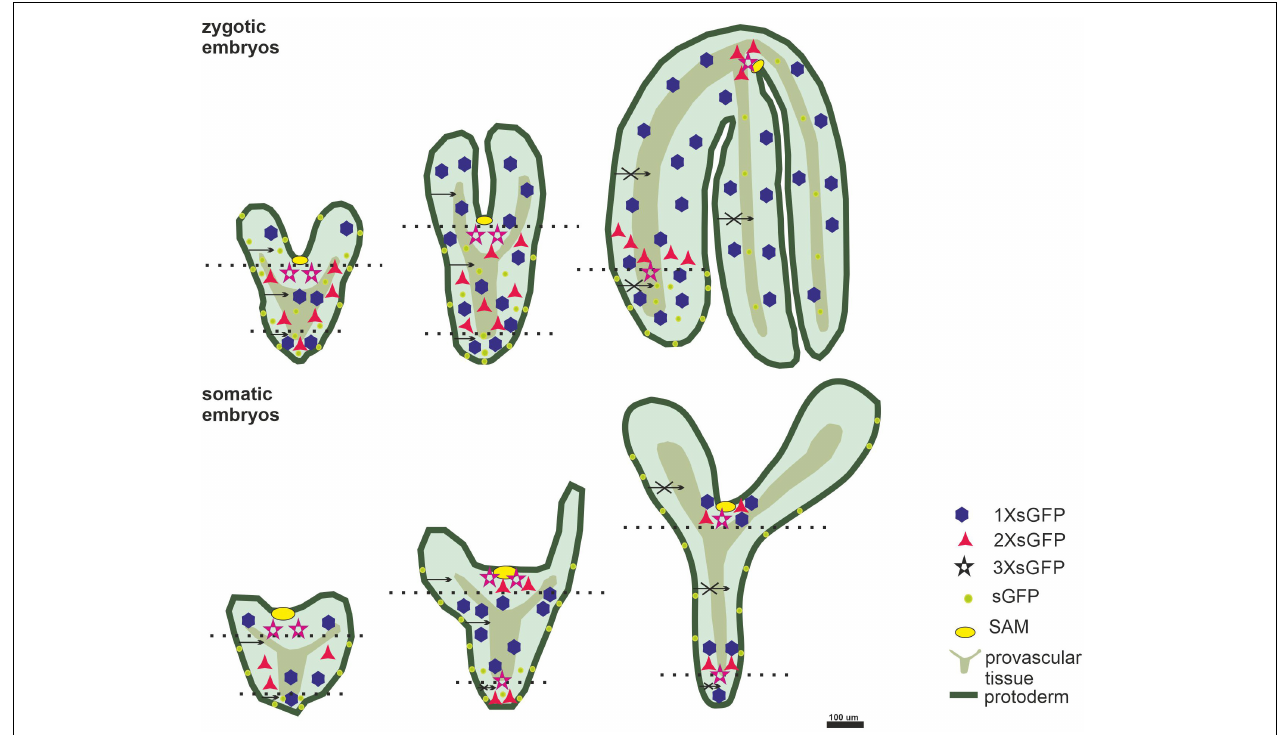
FIGURE 6 | The symplasmic domains identified in the longitudinal direction (between the embryo organs; dotted lines indicate the embryo parts; apical central; basal). In the radial direction – between the embryo tissues; dark green – protodermis; light green – ground promeristem; olive – provascular tissue; octagon – 1XsGFP; triangle – 2XsGFP; star – 3XsGFP; yellow circle – SAM; greenish circle – GFP expressed under pSUC3 ; arrows – the movement in the direction indicated by the arrowhead; a crossed arrows indicates no movement in the direction indicated by the